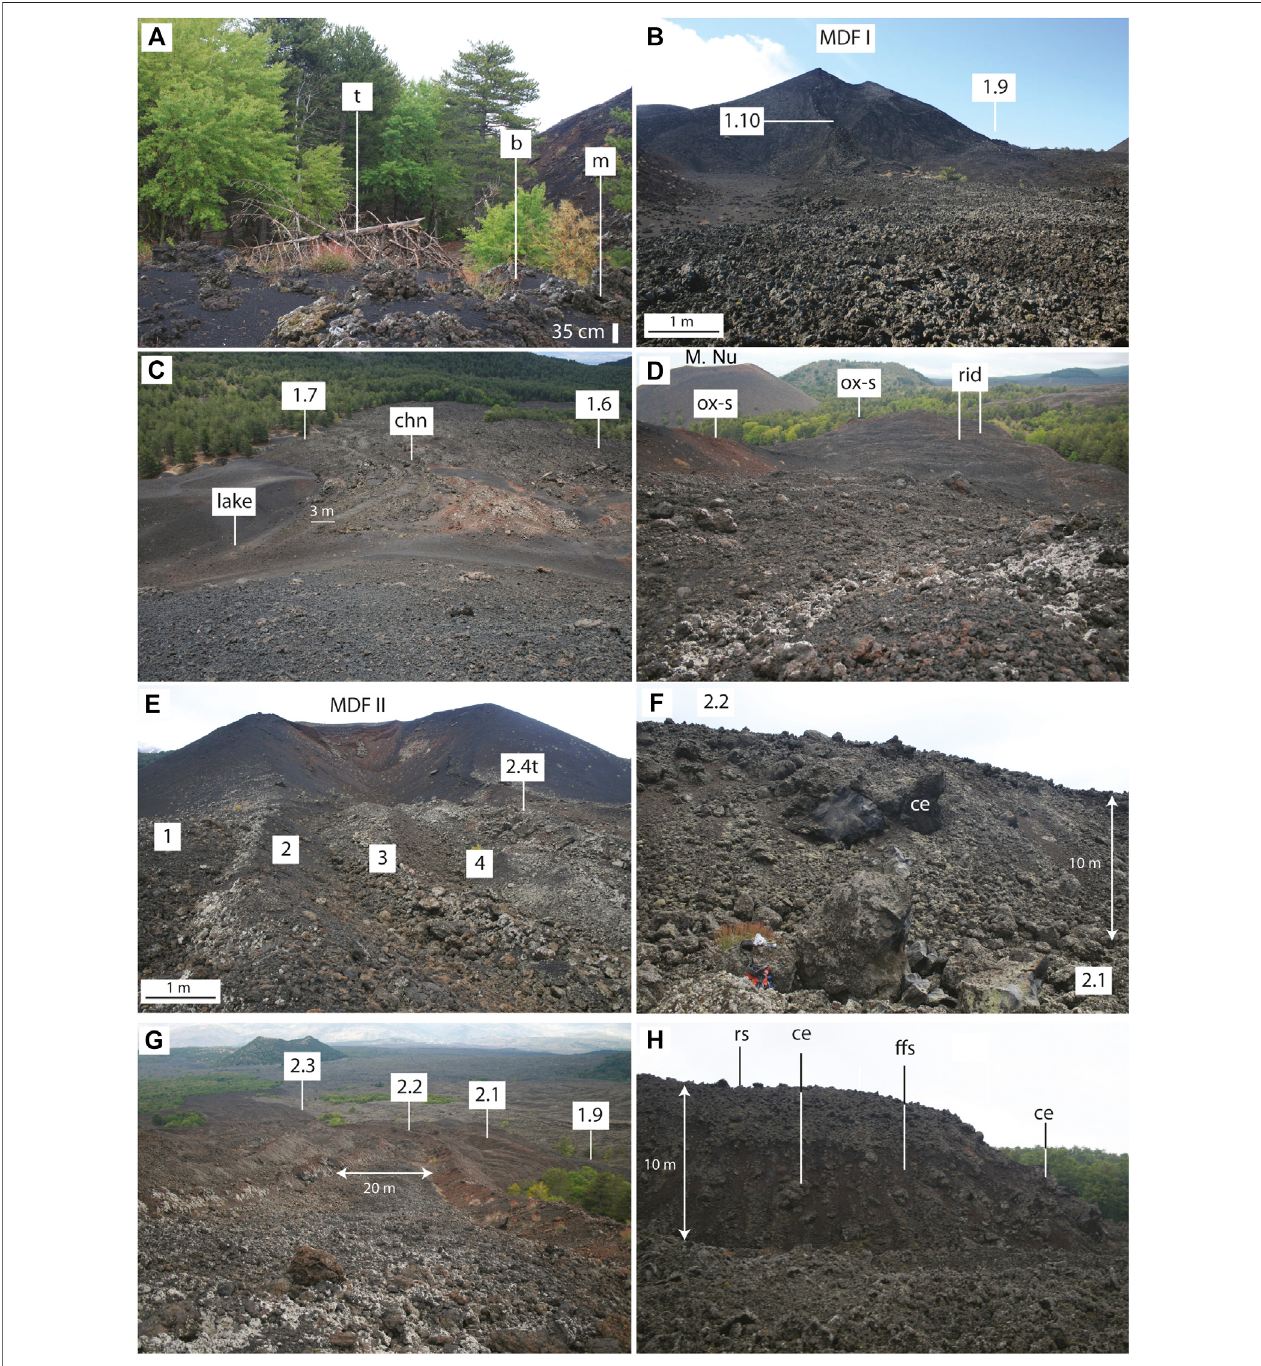
FIGURE 4 | (A) Tree mould (m) in unit 1.3 with its felled tree (t), and location of carbonized wood, labeled “ b ” . (B) View south towards MDF I over the 1.10 ’ a ’ a unit (scale bar is for lava surface in the foreground). Pits and toothpaste lava associated with late stage extrusion from the vents feeding 1.9 and 1.10 are apparent as indicated. (C) View looking south from the summit of MDF I of units 1.6 and 1.7. Incipient channel is marked (chn) as is the “ lava lake ” source of unit 1.6 (lake). (D) View looking north down unit 1.5 (distance to fl ow front is 450 m) showing cross- fl ow ridges (two of which are marked as labeled “ rid ” ) and lava balls (Monte Nuovo “ M.Nu ” in background). Ox-s show locations where oxidized scoriae were sampled (Supplementary Table) . (E) View west into MDF II showing the right-bank (north) channelleveesofPhaseII ’ a ’ aunits 1(2.1), 2(2.2), 3(2.3) and 4(2.4); scalebar isfor lavasurface intheforeground. Toothpaste lavaassociatedwith latestage extrusion intotheheadofthe2.4channelislabeled “ 2.4t ” . (F) Leveeofthe2.2 ’ a ’ aunitwhereitoverlies2.2,withdense,massivecoreextrusions( “ ce ” ). (G) Viewlookingwestfrom MDFIIdown theproximalportion ofthe2.2lavachannel,levees associatedwiththe2.1and2.3channelsarealsolabeled,asisthe fl owfrontof1.9. (H) Flowfrontof2.3 showing the three facies of distal ’ a ’ a at Etna (Kilburn and Guest, 1993).